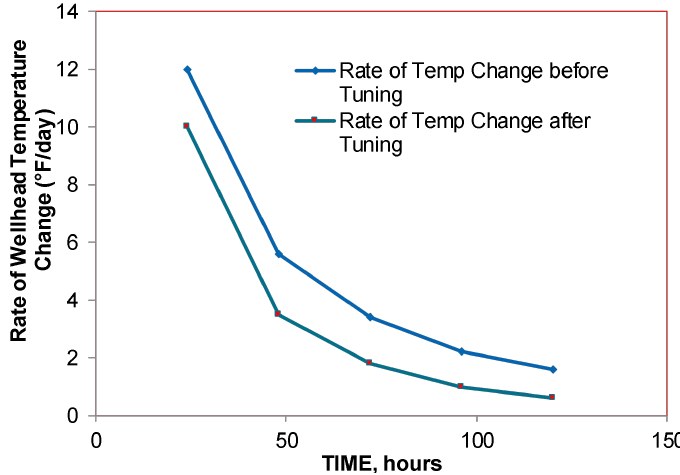
Figure 9—Model tuning with WHT change rate.